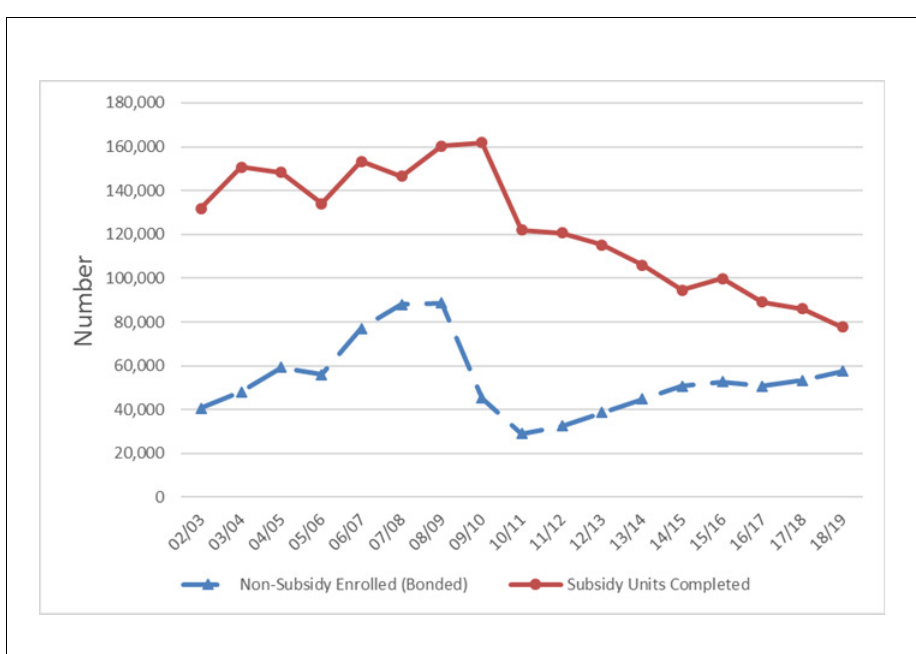
Figure 1: Delivery of houses (adapted from Mahachi 1